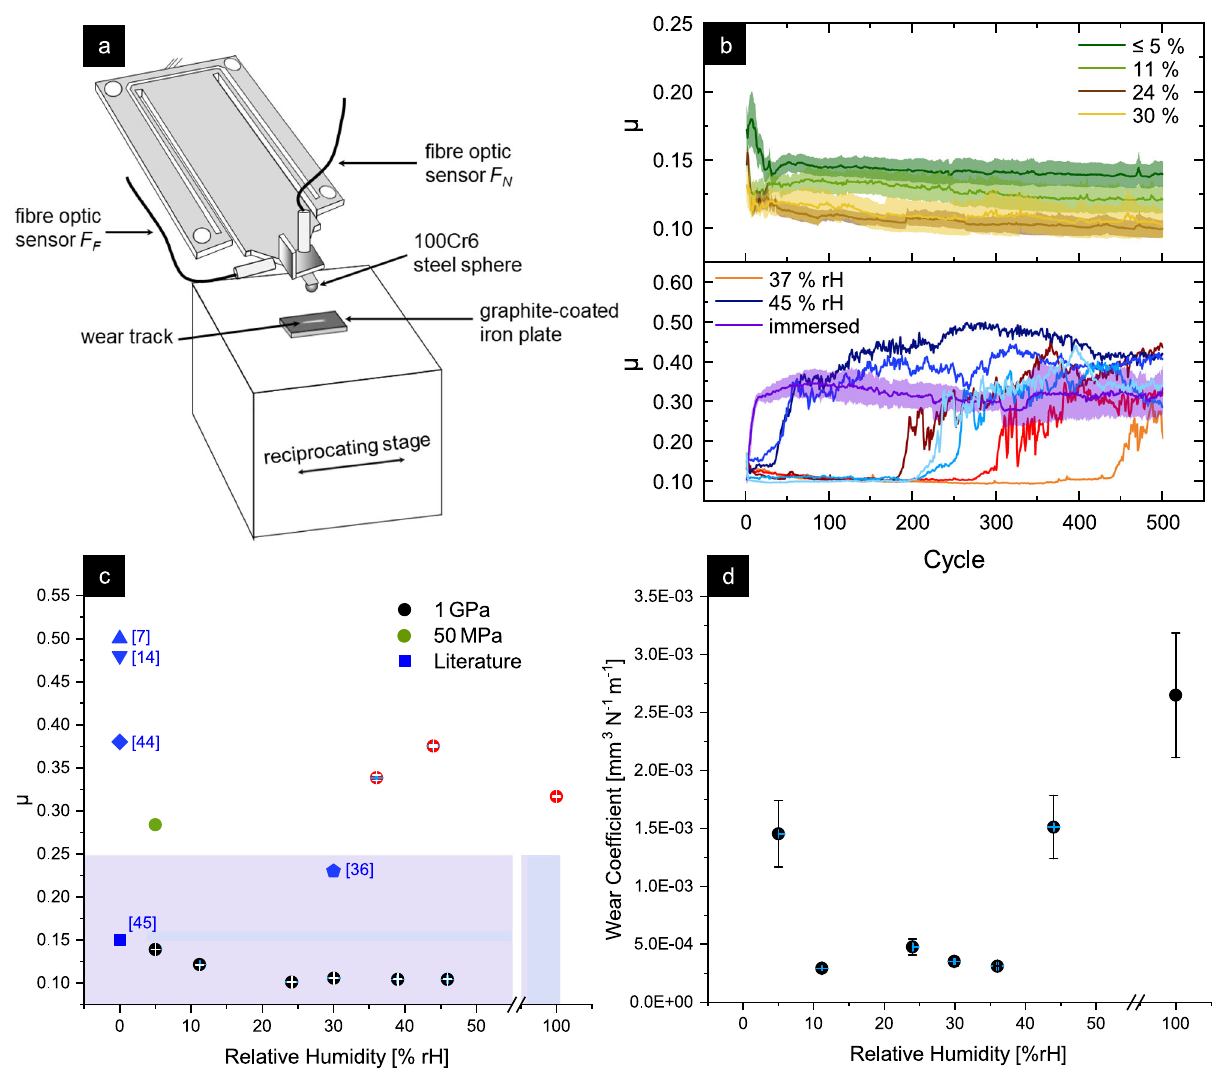
Fig. 2 | Tribometric setup and experimental friction and wear results. a Schematic of the experimental setup. b Coef fi cient of friction ( μ ) over the experimental duration for various humidity values. Each experiment was repeated three times for500 cycles each at a strokelength of1mm, a velocity of 0.5mms − 1 , and a normal force of 402mN. For the experiments conducted at lower humidity RH ( ≤ 30%) the average of three consecutive measurements for each humidity is shownintheupperpanel.Thestandarddeviationofthreemeasurementsismarked as the semi-transparent areas. In the lower panel all measurements at the higher humidityvalues(37%and45%RH)areshown(shadesoforange/red:37%RH,shades